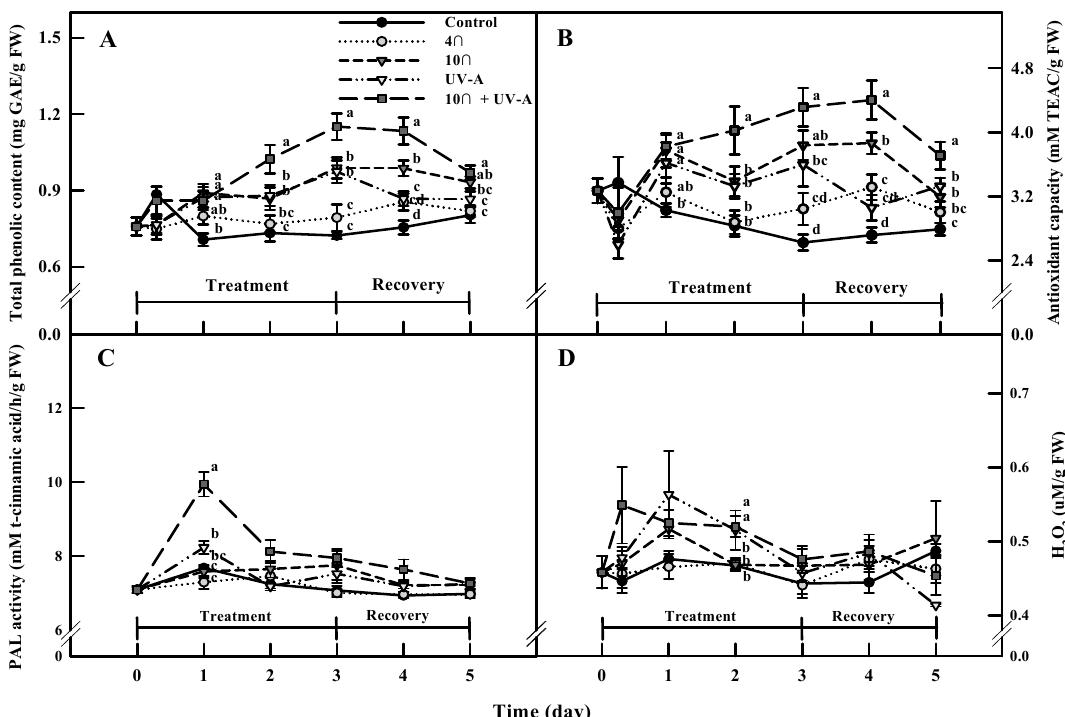
Figure 3. Total phenolic content ( A ), antioxidant capacity ( B ), phenylalanine ammonia-lyase (PAL) activity ( C ), and hydrogen peroxide levels ( D ) in kale subjected to chilling, UV-A, and combined stress treatments for 3 days, followed by 2 days of recovery. The vertical bars indicate standard errors ( A and B , n = 9, C and D , n = 5). Different letters above the bars indicate significant differences at p -value < 0.05.